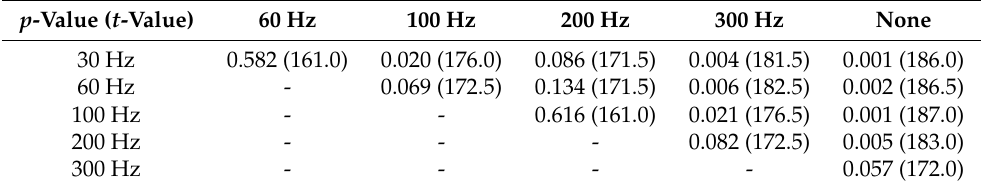
Table 2. Comparison of heaviness ranks. p -values and ( t -values) between vibration conditions in Task 1-2 (Wilcoxon signed-rank test with Bonferroni